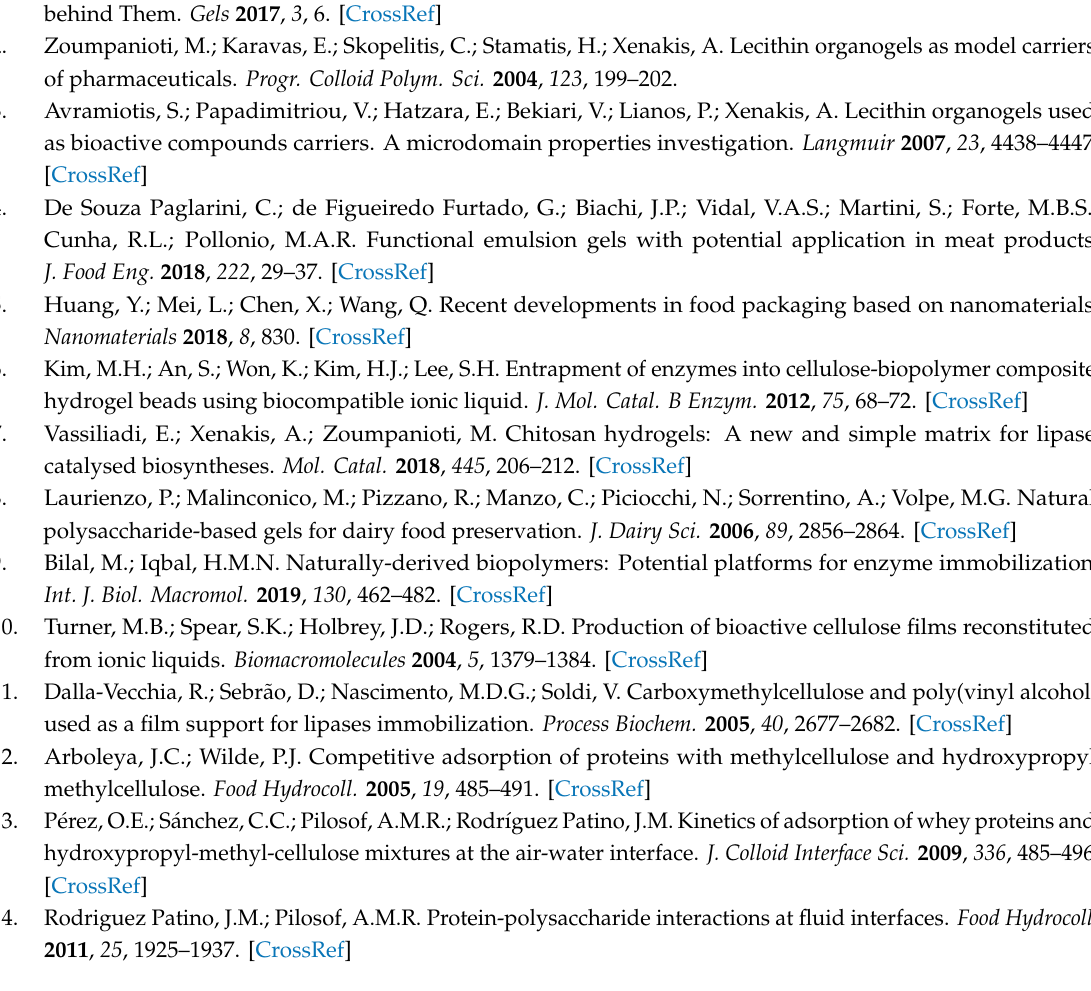
Details of EPR analysis. Figure S1: Plots of rotational correlation time, τ R , vs. water content of Systems A, B, and C for the di ff erent spin probes used. Figure S2. Plots of hyperfine splitting constant, A N , vs. water content of MBG Systems A, B, and C for the di ff erent spin probes used. Figure S3. Spectra of 12-doxyl methyl stearate (12-DMS) in AOT microemulsion and in Systems A, B, C. Figure S4. Spectra of 5-doxyl decane (5-DD) in AOT microemulsion and Systems A, B, and